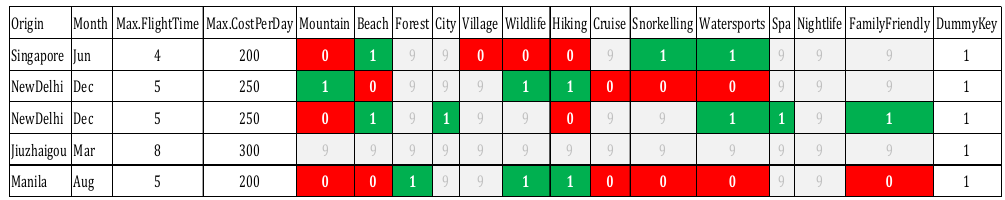
Figure 21. Integration of the augmented big data analytics.